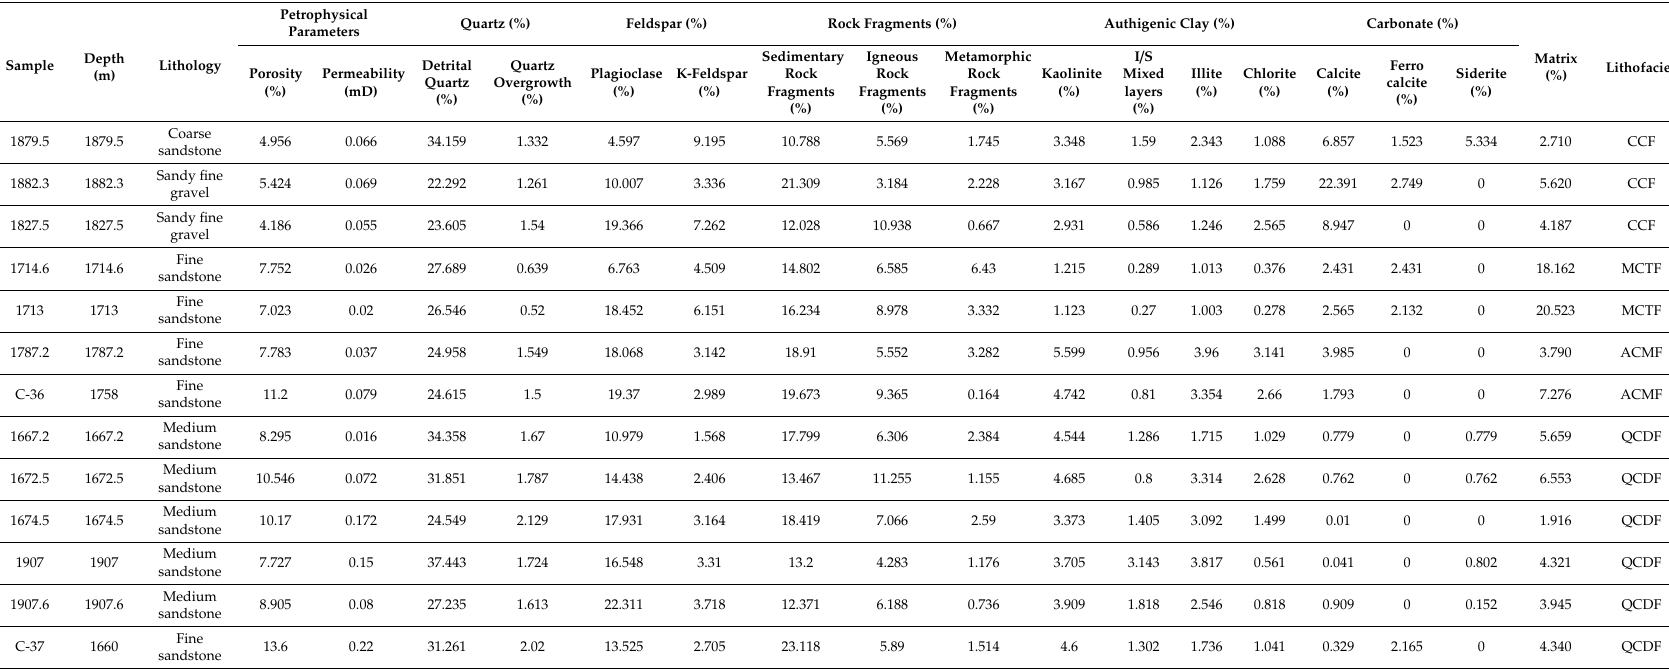
Table 1. Petrophysical parameters and mineralogical compositions of 13 tight sandstone